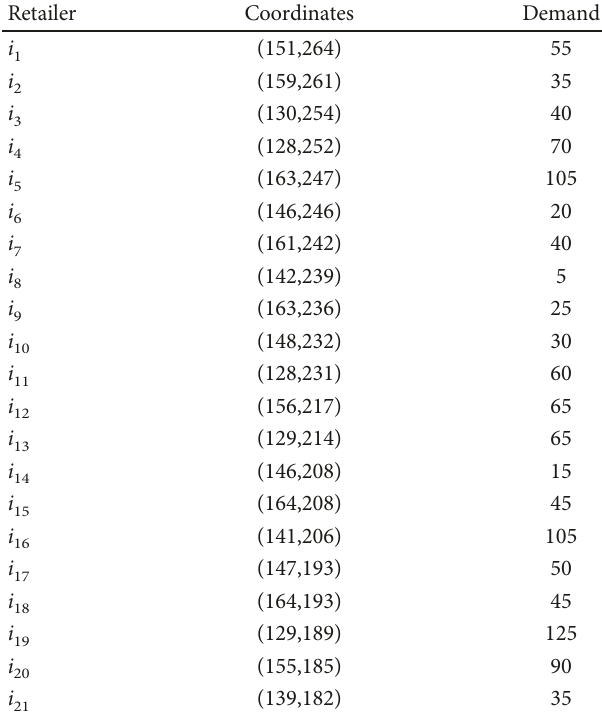
Table 1: Gaskell67-21 × 5